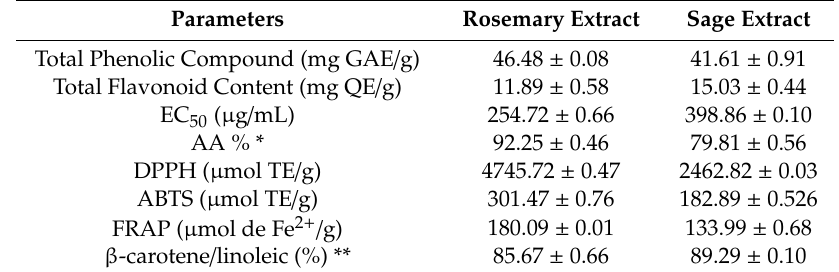
Table1. Totalphenoliccontent,totalflavonoidcontentandantioxidantactivityofrosemaryandsageextracts.